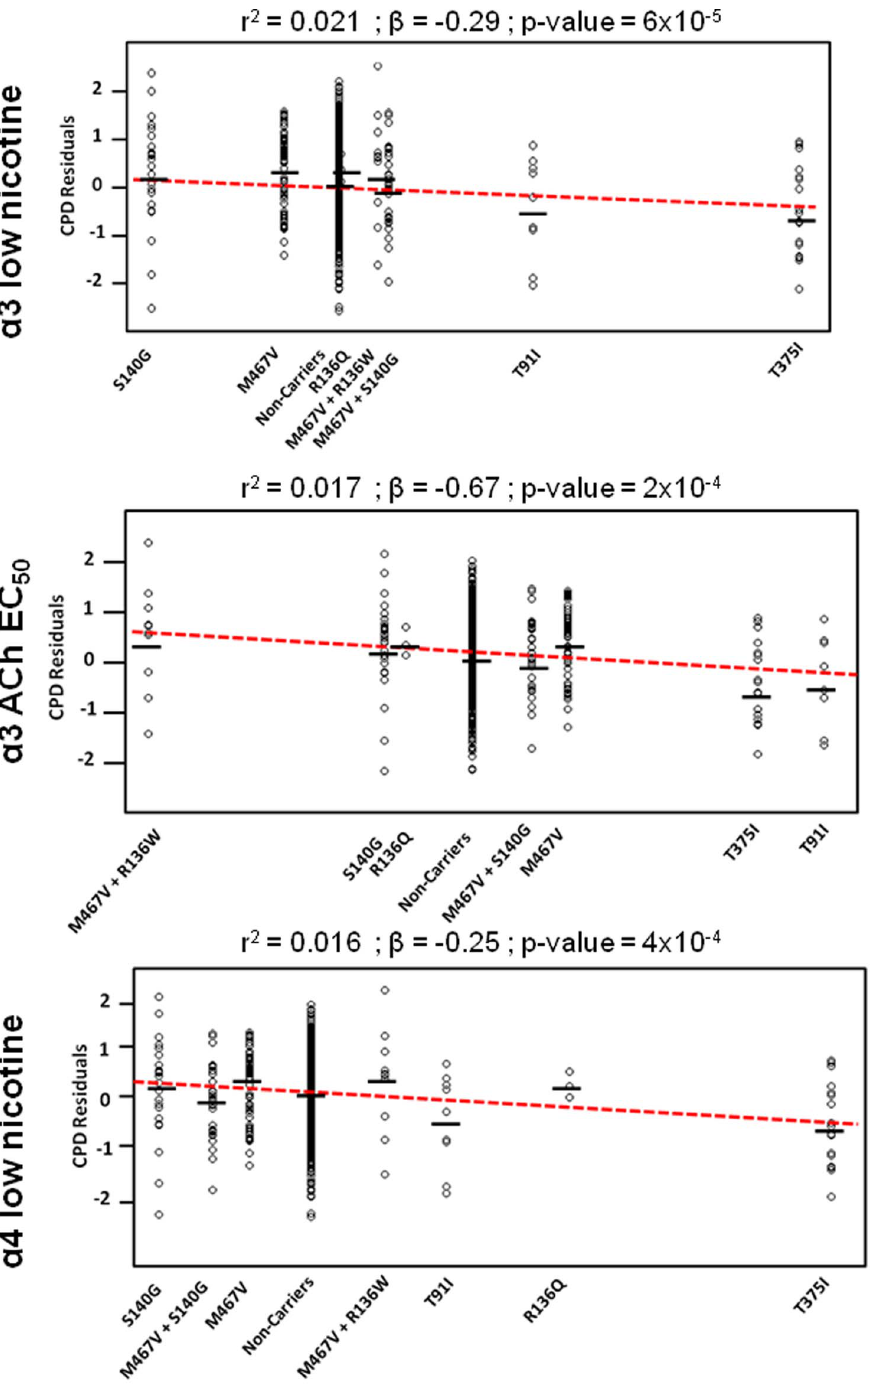
Figure 4. Correlation between Functional Parameters and CPD. The panels show the distribution of log(CPD) after correcting for age and sex, plotted against the relative parameter values for the 3 functional parameters that produced a significant association. The dashed red line is the estimated linear relationship. Horizontal lines mark the mean CPD residuals of carriers of each variant. Linear regression was performed in R. Singleton variants were included by weighting them by the parameter of the non-singleton variant (or wild-type) with the closest parameter estimate (see Results and Tables 2 and 3).